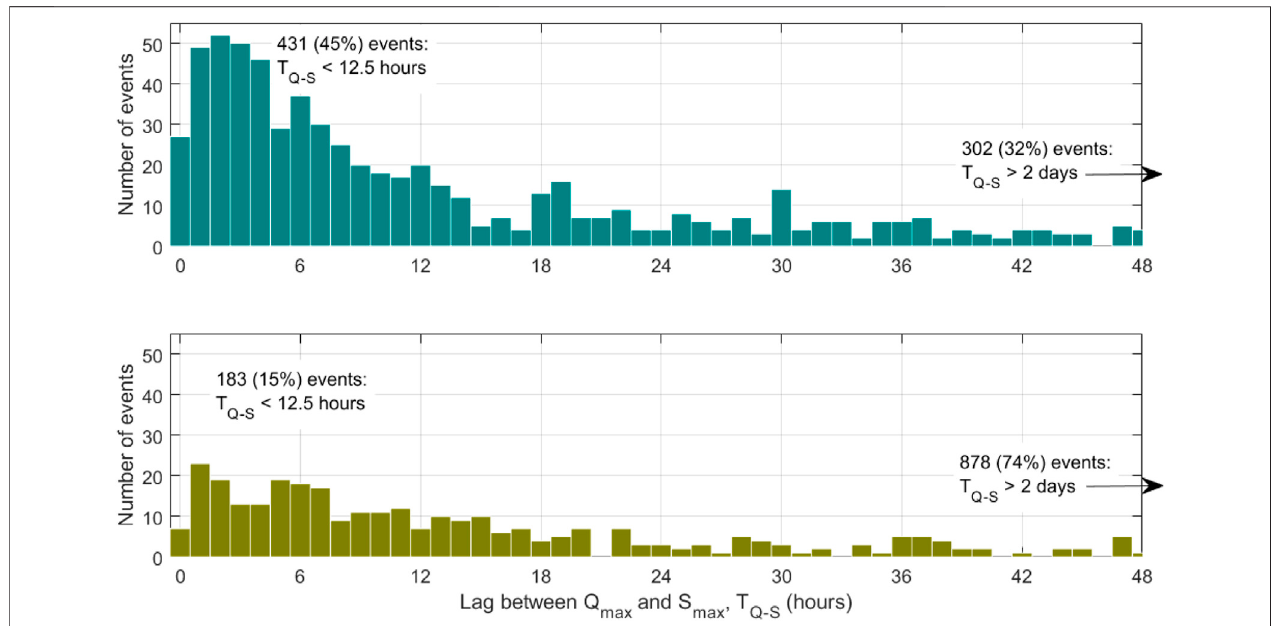
FIGURE8| Histogramsshowingtherelativetimelaginhoursbetweenpeakriver fl ow(95 th percentile fl ow)andthenearest95 th percentileskewsurge(T Q-S ),for (A) Dy fi and (B) Humber.